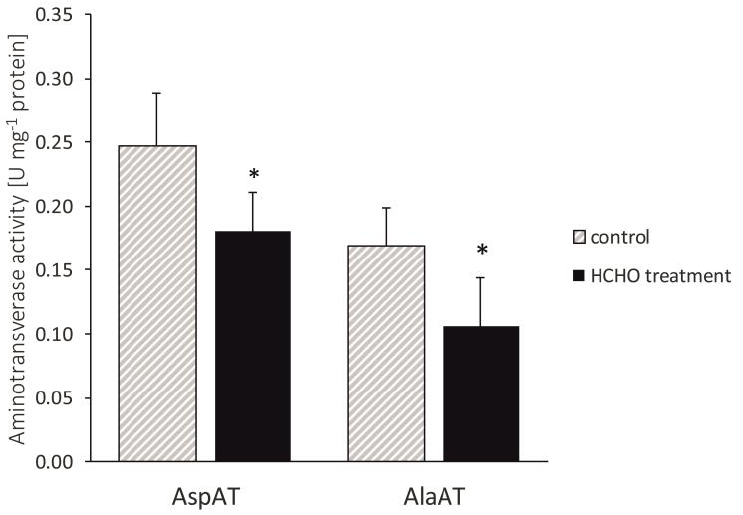
Figure 3. Effect of treatment with gaseous formaldehyde applied as 20 mg m − 3 on AspAT and AlaAT activities in C. comosum leaf tissues after the 48 h of plant exposure. The data are means ± SD. * indicates values that differ significantly from the control at p < 0.05.